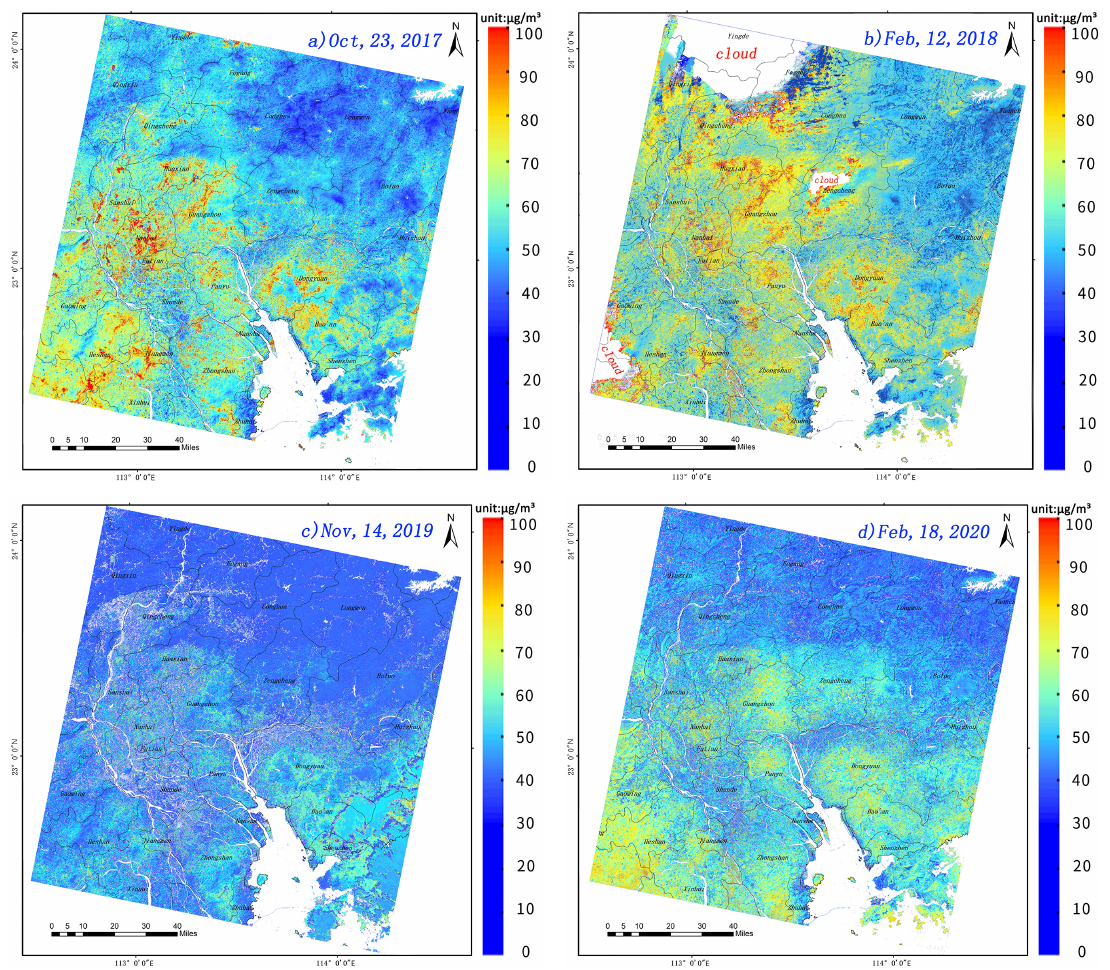
Figure 6. Spatial and temporal distribution of PM 2.5 mass concentrations in the PRD for a certain day in different years.